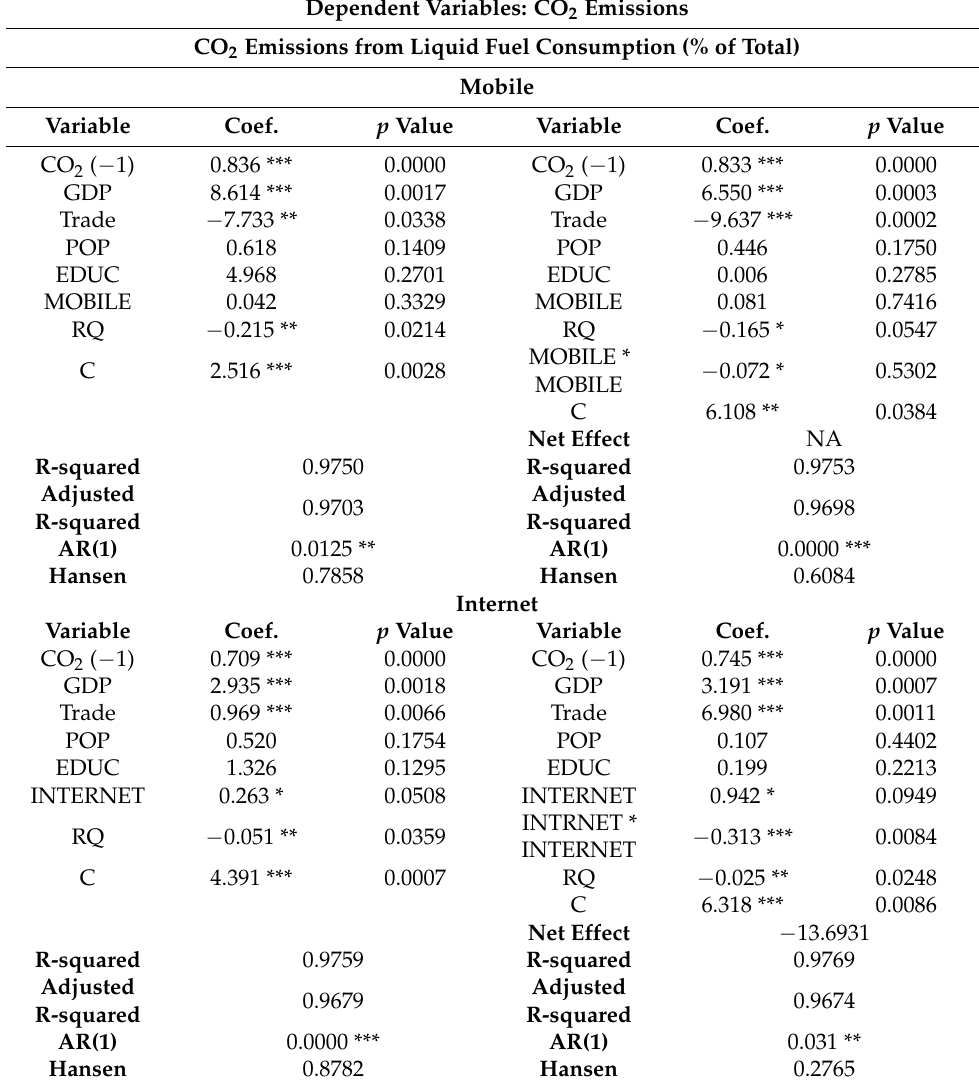
Table 5. Empirical